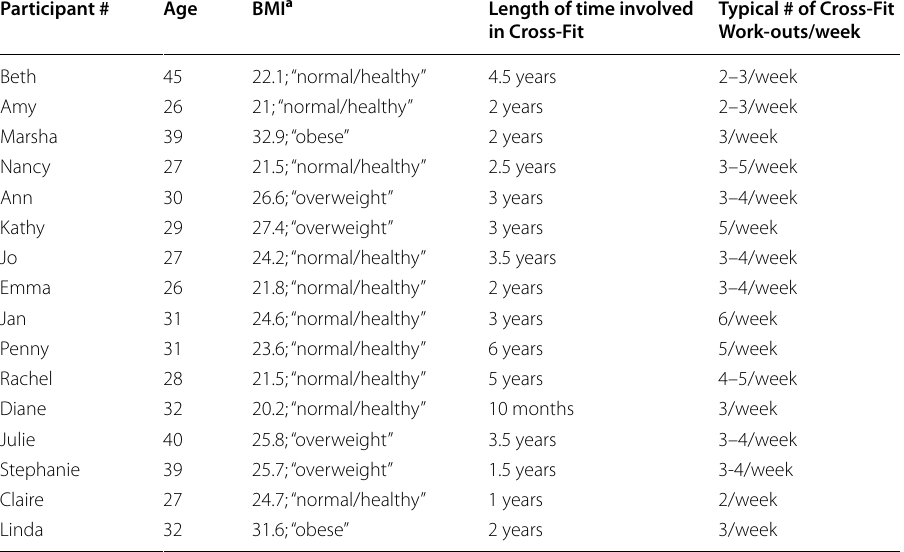
Table 1 Selected participant background